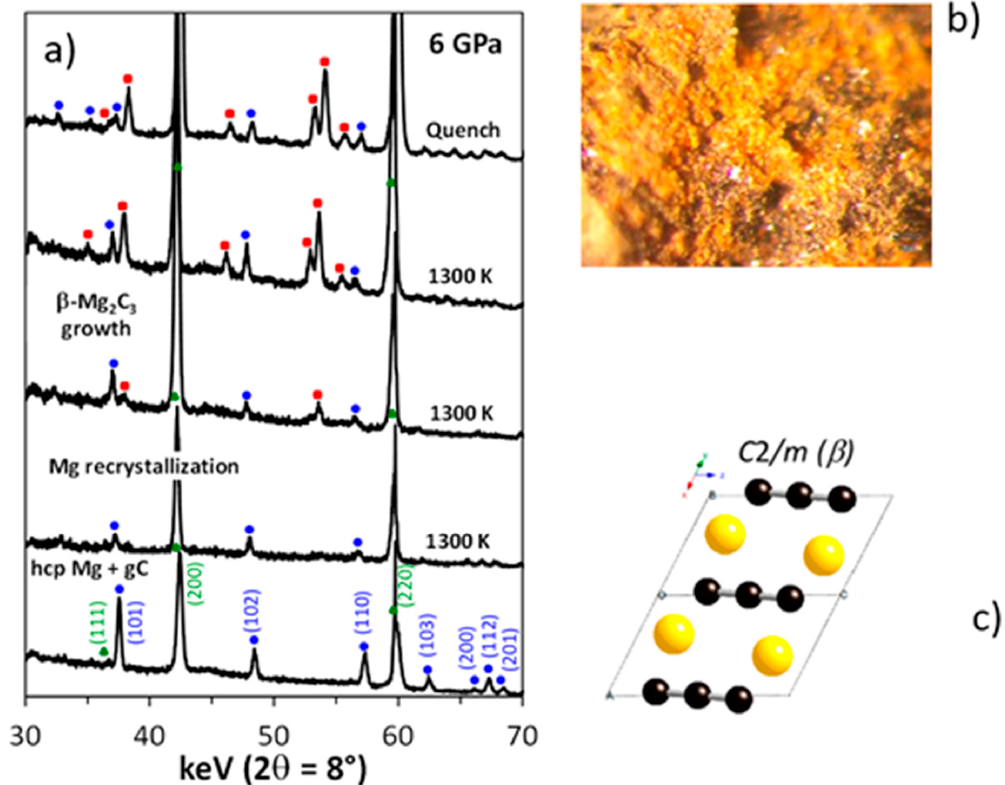
Figure 9. ( a ) In situ observation of synthesis of Mg 2 C 3 (red circles) by chemical reaction of Mg (blue circles) with powder of glassy carbon using energy-dispersive XRD with white beam of synchrotron radiation in a Paris–Edinburgh-type press at SOLEIL [16]. Green circles show the MgO capsule material. ( b ) Optical microscope picture of as synthesized β -Mg 2 C 3 powder. ( c ) Monoclinic crystal structure of β -Mg 2 C 3 resolved by combination of in situ powder XRD and evolutionary structural algorithm USPEX [16]. Yellow balls indicate the position of Mg atoms, while black balls—of C atoms. (Figure adapted with permission from [16]. Copyright 2014 American Chemical